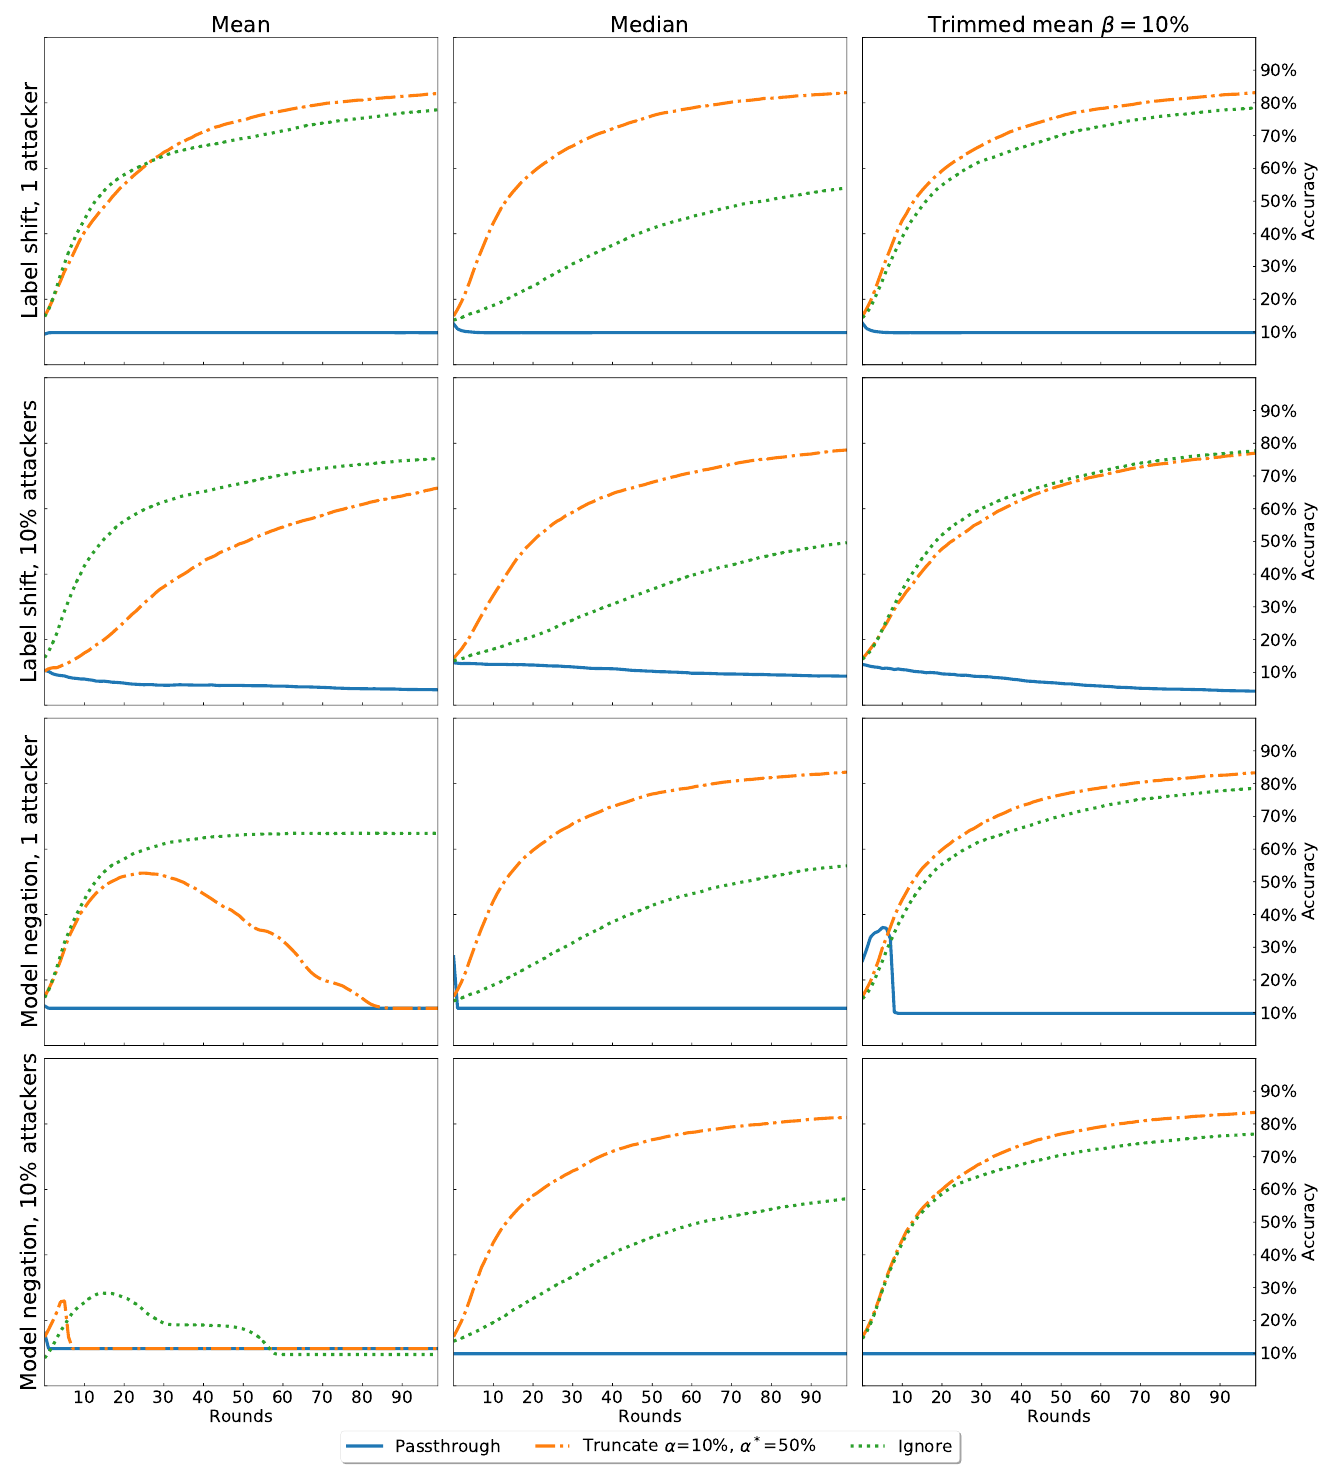
Figure A2. Accuracy by round under Byzantine attacks for the MNIST experiments. In the first two rows, Byzantine clients perform a label shifting attack with 1 and 10% attackers, respectively. In the last two rows, we repeat the experiment with a model negation